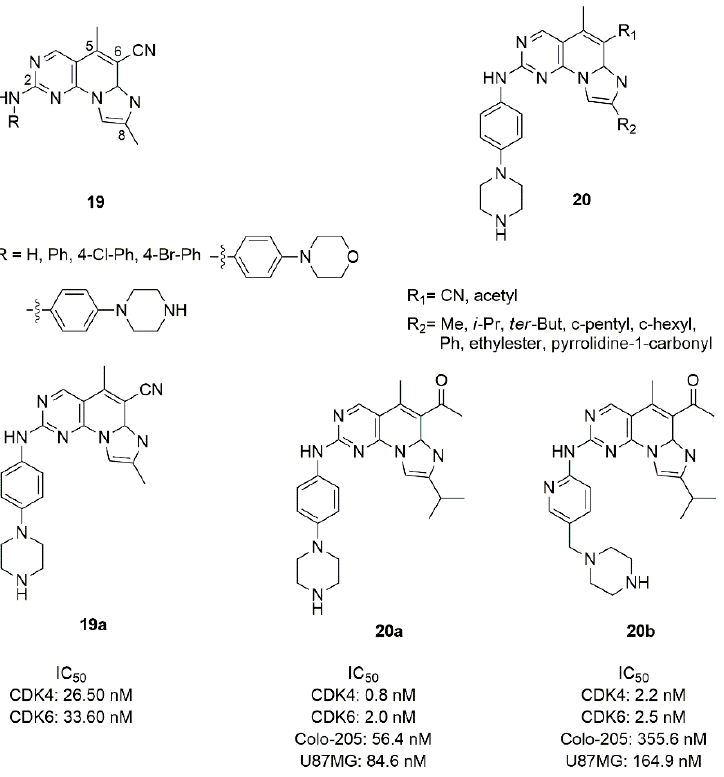
Figure 10. Structure of imidazo[10,2 ′ :1,6]pyrido[2,3-d]pyrimidine derivatives. In the series 19 , the fused tri-heteroaryl structure was substituted with a methyl in C5 and C8, cyano in C6, while the amino group in C2 was substituted by phenyl or para- substituted phenyl groups. This type of modification did not sufficiently improve the activity, and compound 19a with the piperazine in para position showed modest inhibition values (IC 50 CDK4 = 26.50 nM, IC 50 CDK6 = 33.60 nM). Keeping constant the piperazine moiety, in the series 20 the C6 and C8 positions were changed by the introduction of methyl, iso -propyl, terz -butyl, cyclopentyl, cyclohexyl, phenyl, ethylester, or pyrrolidine-1-carbonyl in C8, while the cyano group in C6 was replaced with the acetyl one. Compound 20a was the best one of the series in terms of inhibition (CDK4 IC 50 = 0.8 nM, CDK6 IC 50 = 2.0 nM). The piperazine ring of compound 20a was also replaced by saturated heterocycle, distanced by a methyl and a carbonyl linker; alternatively the piperazinyl-pyridine portion was replaced with a fused bicycle. None of these changes improved the inhibition of kinases [79]. Compound 20a demonstrated good activities on Colo-205 (IC 50 = 56.4 nM), and glioma U87MG (IC 50 = 84.6 nM) cell lines, favourable in vitro metabolic properties (microsomal stability, CYP isoforms inhibition), acceptable pharmacokinetic profiles in mice and rats, antitumor efficacy with controllable observed side effects in xenograft in vivo